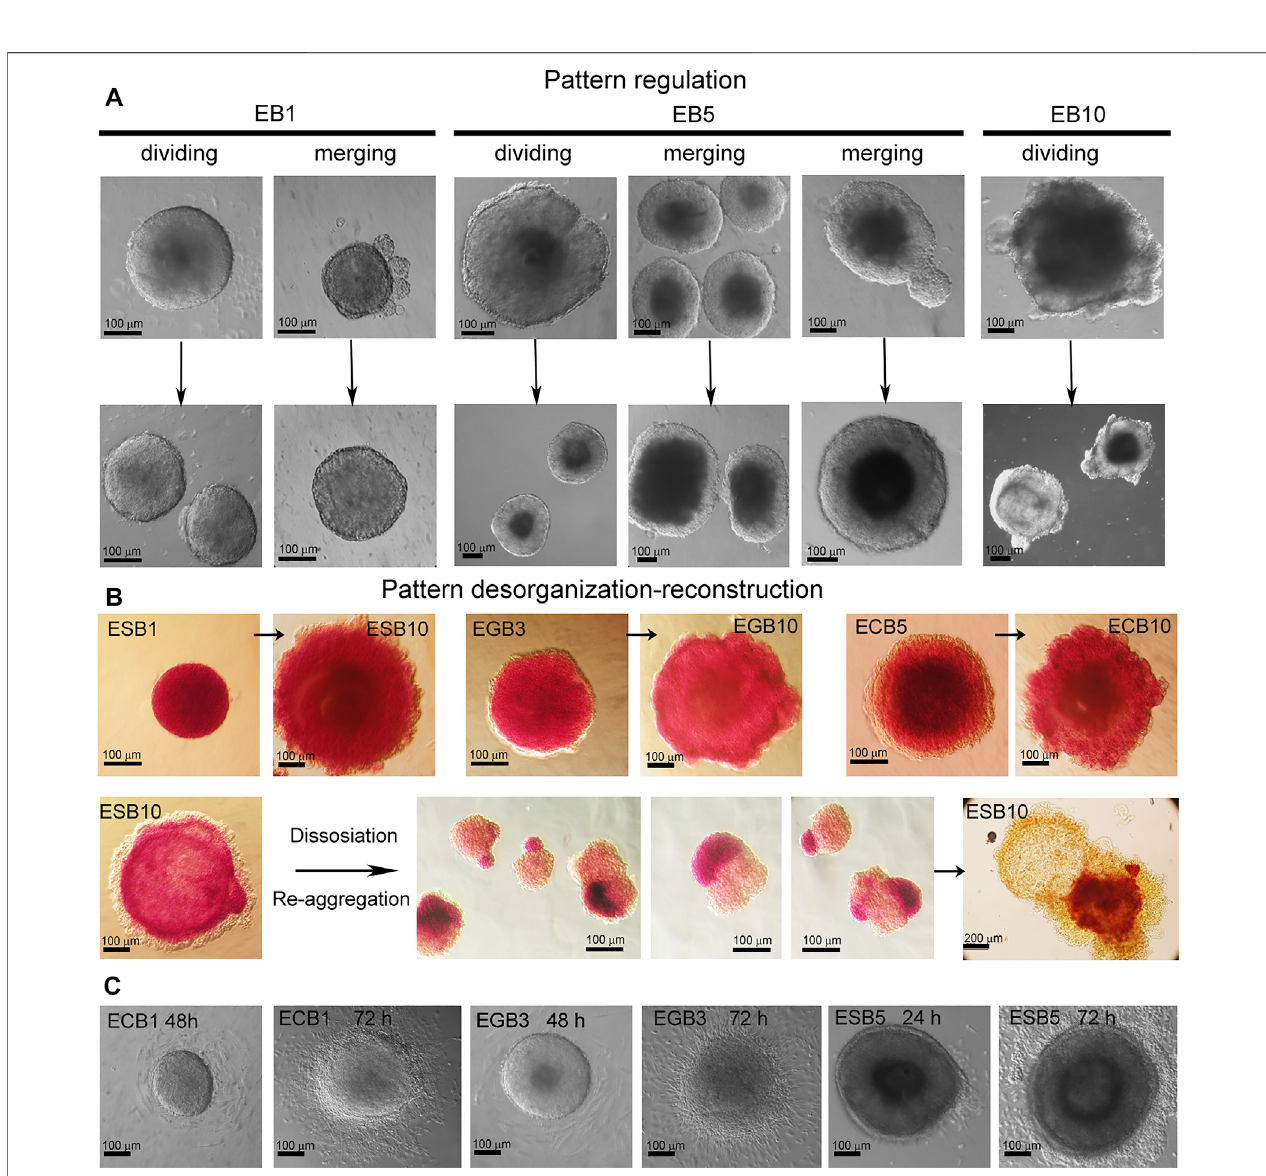
FIGURE 8 | EB pattern regulation after dividing, merging, and disorganization. (A) Representative images of pattern regulation in the EB1, EB5, and EB10 after dividingandmerging.Aftermergingordividing,theresultingEBsrestoredtheirpatternsandarchitectureandcontinuedfurtherdifferentiationinallcases(100%)(10EBs/ per stage per cell line; three experiments; N = 120 for each cell line). (B) Pattern disorganization-reconstruction by dissociating EBs and re-aggregating cell suspension for 72 h (5 EBs/per stage for each cell line; three experiments; N = 60 for each cell line). Dissociated EB10 cells (100 cells/per drop) de novo self-organize and sort withintheaggregateinto arbitrary spatial arranged cellular domains consisting ofhomogeneouspopulations ofExEn and Epilcells. Duringfurther differentiation, allthree typical EB patterns are restored but with varying degrees of symmetry. Cavities are formed within the Epil and sometimes ExEn domains. ALP activity was detected in EBs and reconstructed cell aggregates with asymmetrical patterns. (C) Representative images of spherical shape loss and pattern disorganization after the attachment of EB1, EB3, and EB5 to cell culture dishes at 24 – 72 h. EB1-5 cells can attach to the dish surface and migrate, while EB10 can not.